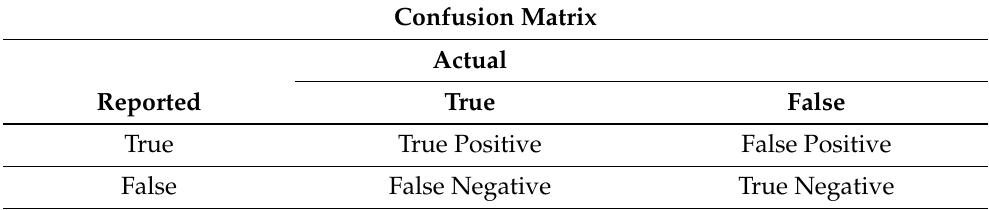
Table 5. Confusion